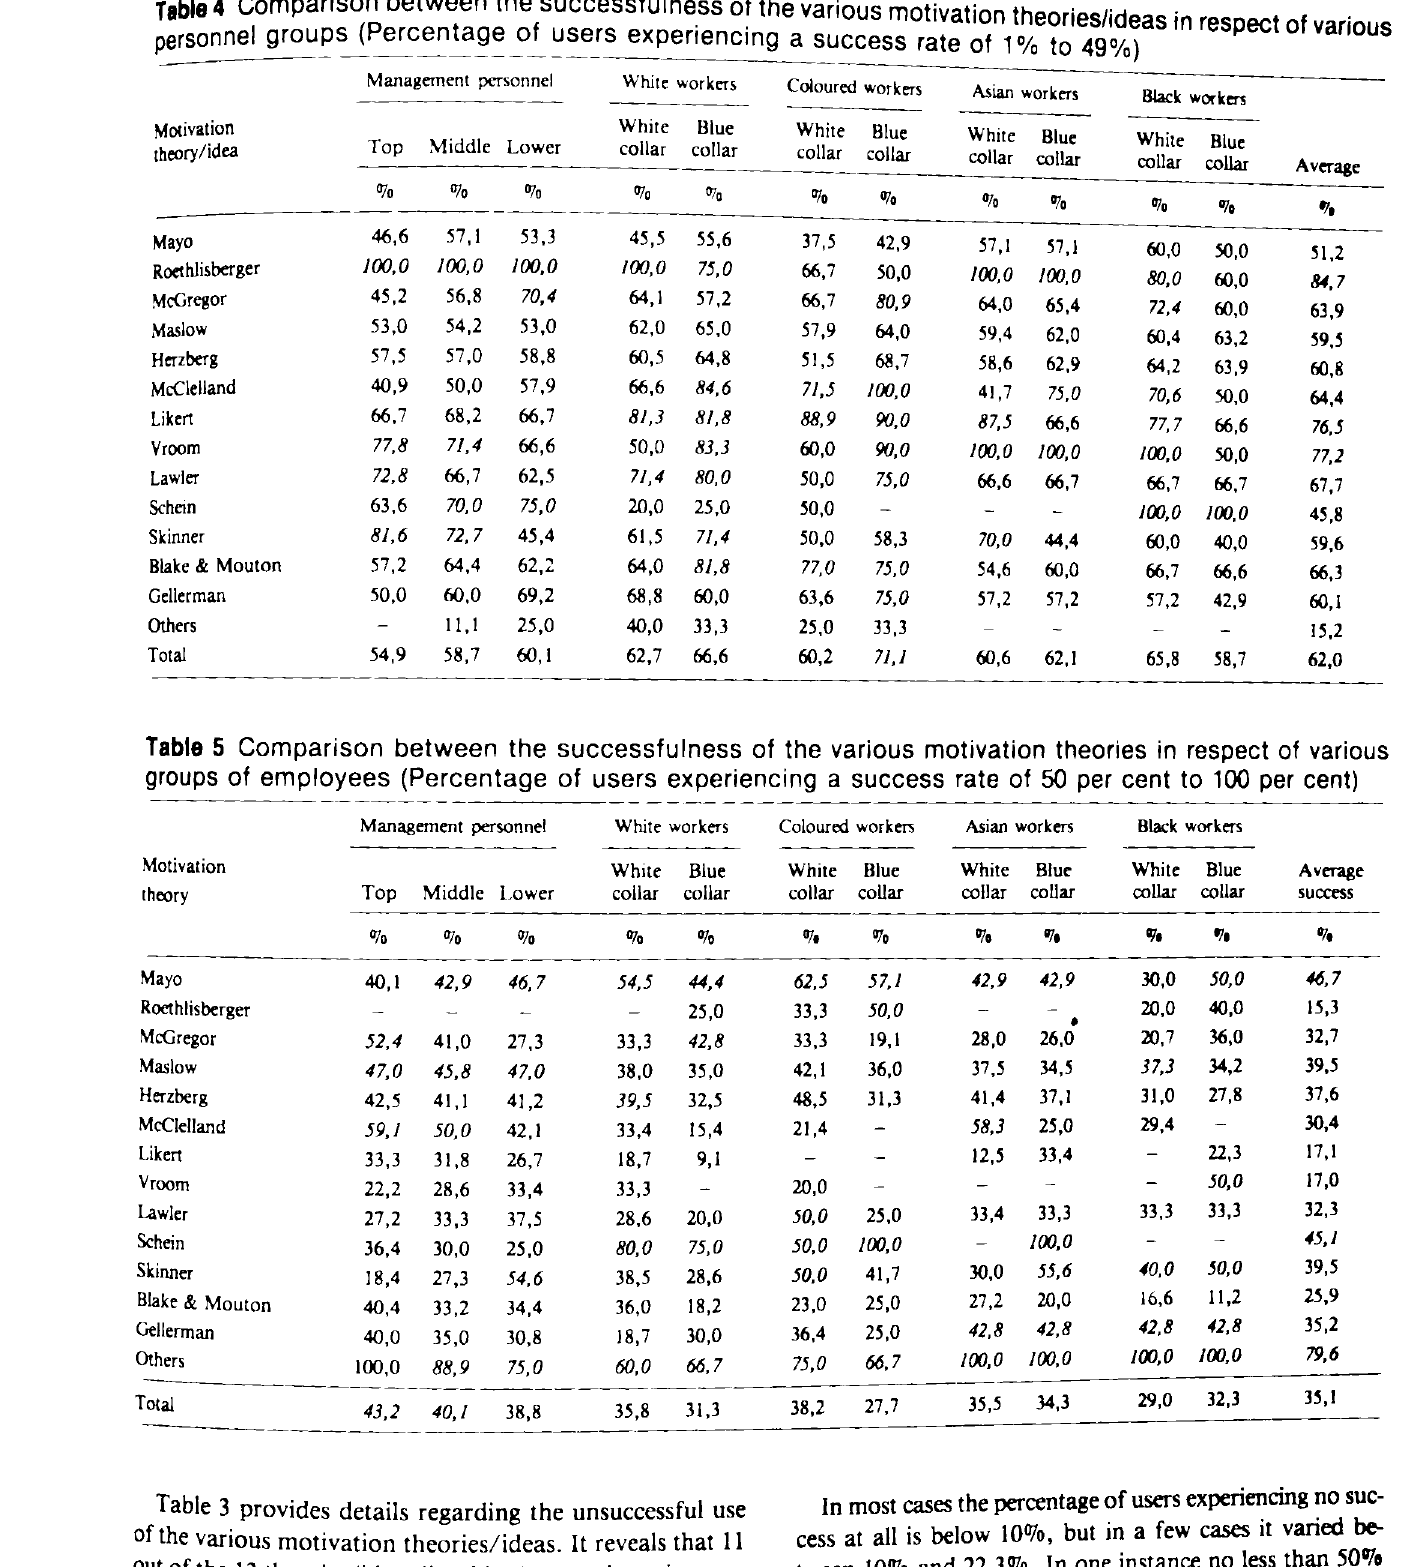
Table 4 Comparison between the successfulness of the various m · . .